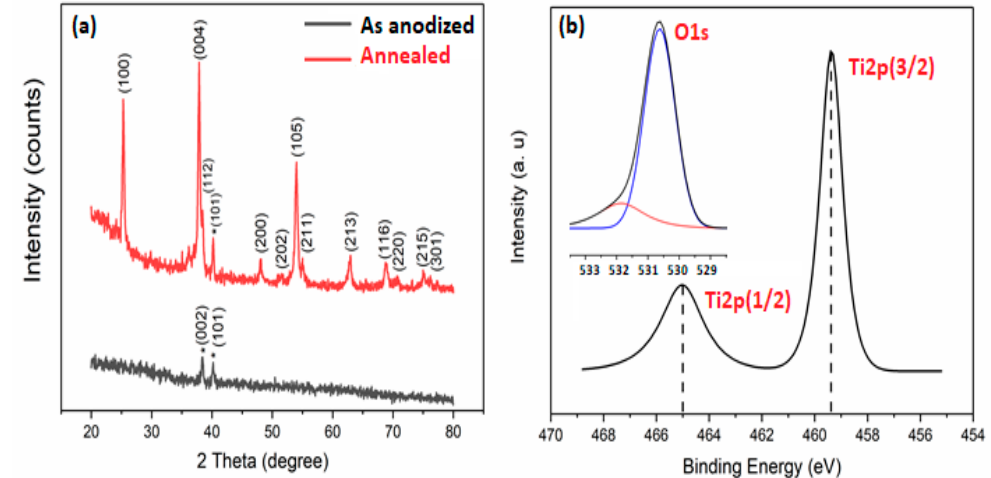
Figure 2. ( a ) X-ray diffraction pattern of the as-anodized and post-annealed TiO 2 nanotubes ( b ) X-ray photoelectron spectra of the Ti2p (inset shows the O1s region of the TiO 2 nanotube).